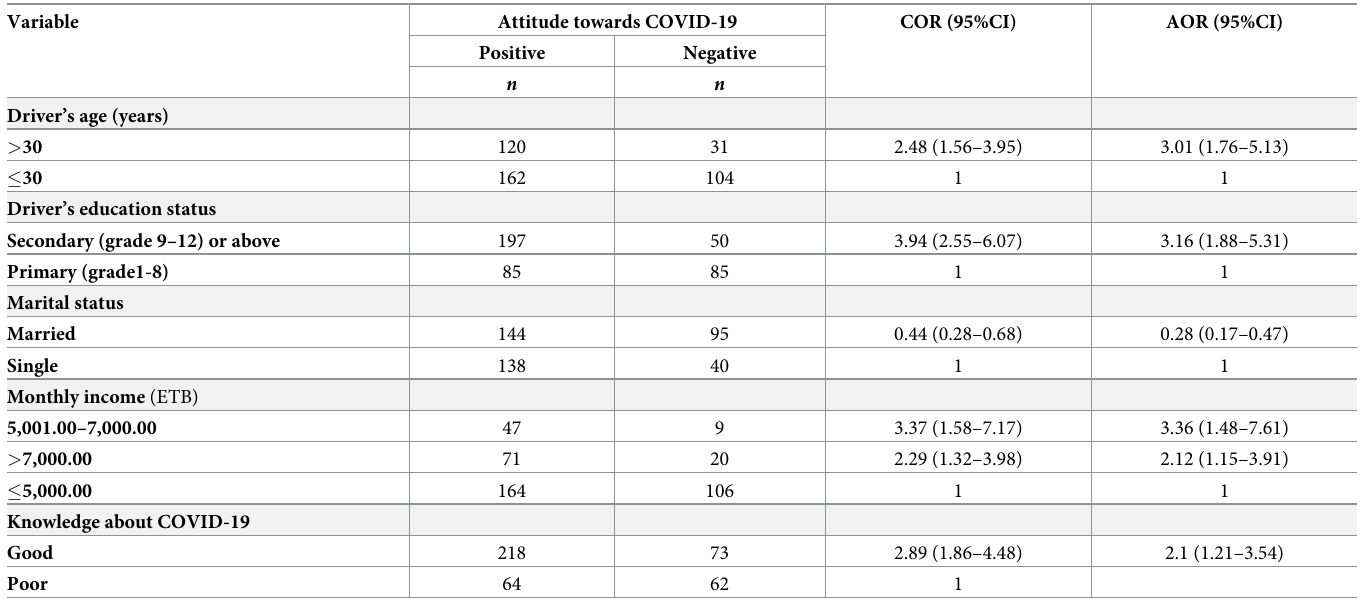
Table 6. Factors associated with good attitude towards COVID-19 among taxi drivers from multivariable analysis in Dessie City and Kombolcha Town, Ethiopia, July to August 2020.